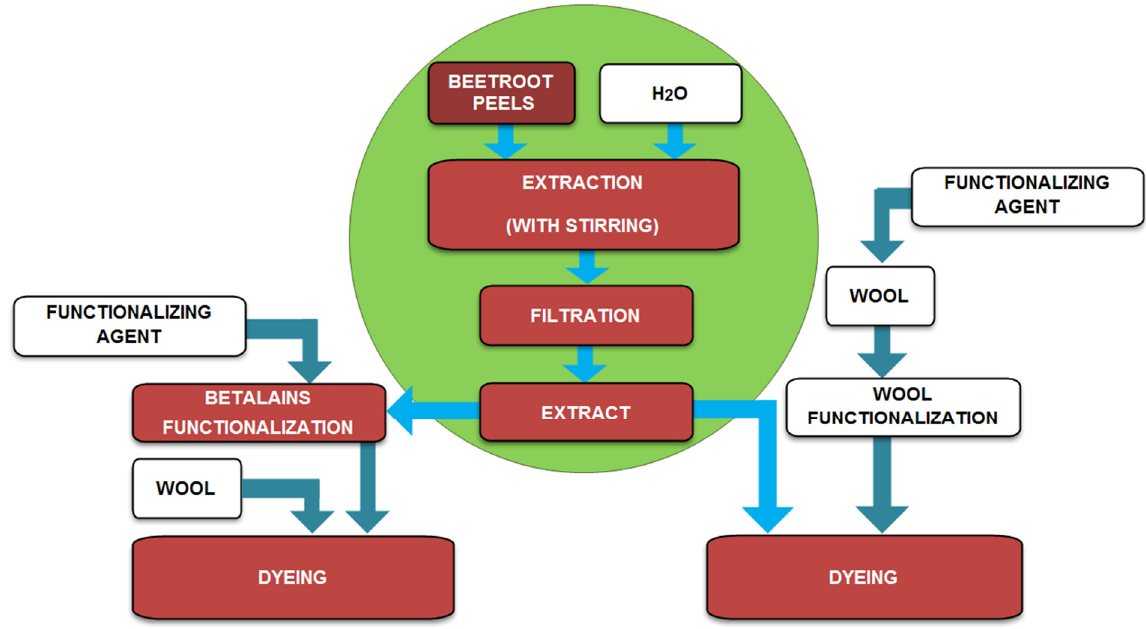
Figure 1. Diagram showing the steps performed for betalains extraction, functionalization treatments, and wool dyeing.